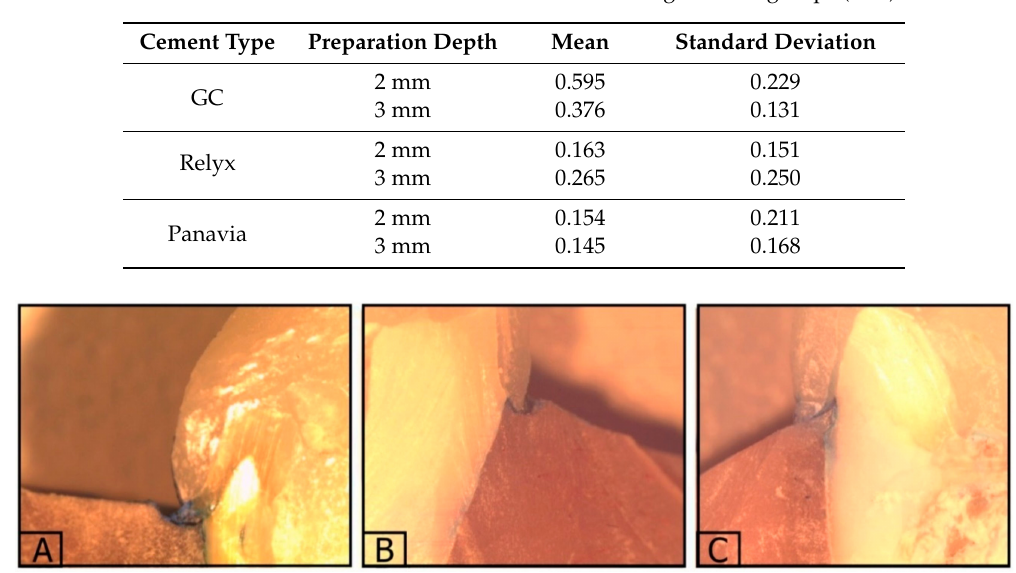
Table 2. Values and standard deviations of microleakage for test groups (mm).